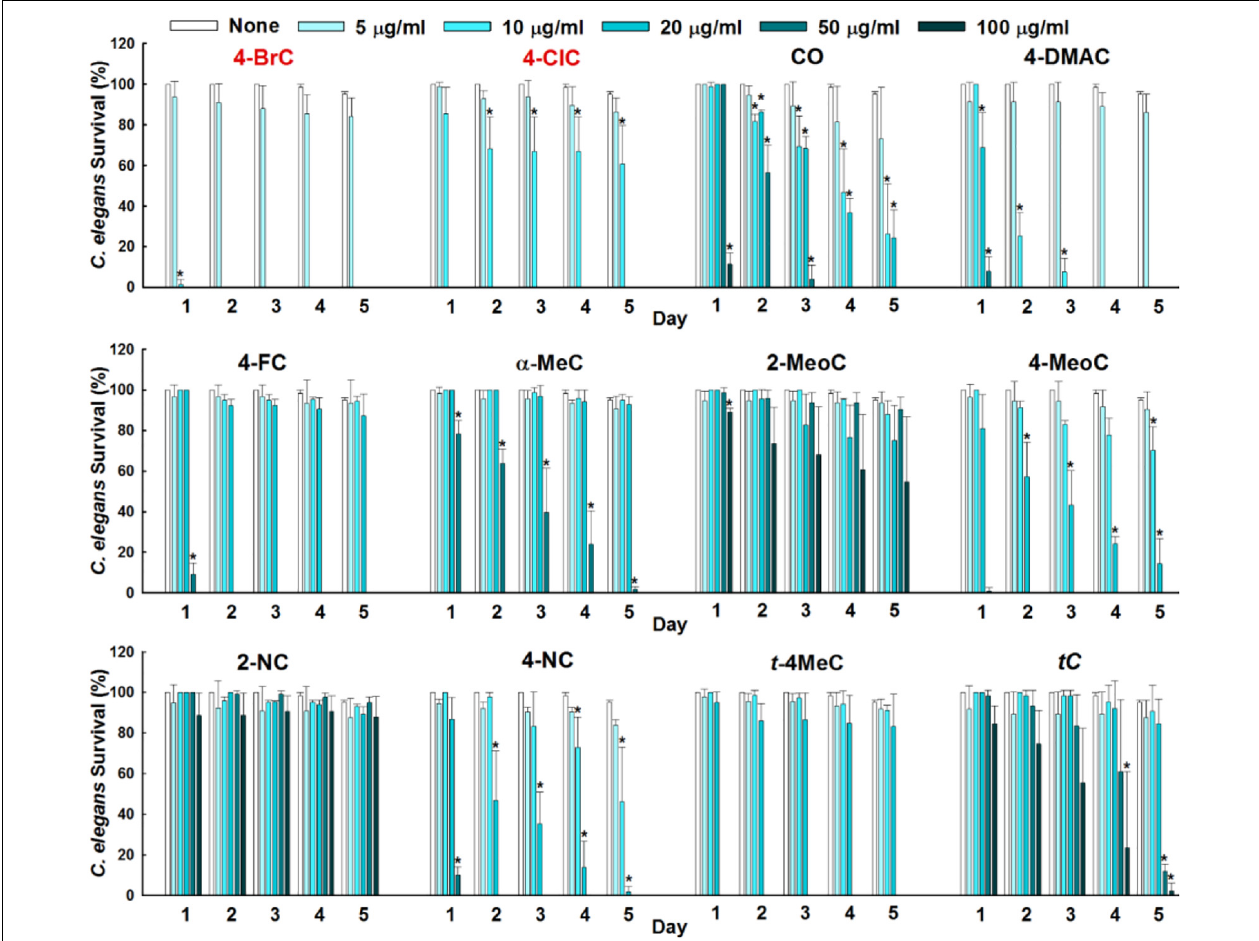
FIGURE 6 | Anthelmintic activities of cinnamaldehyde analogs were evaluated against C. elegans for 5 days. Error bars indicate standard deviations. * P < 0.05 vs. non-treated controls